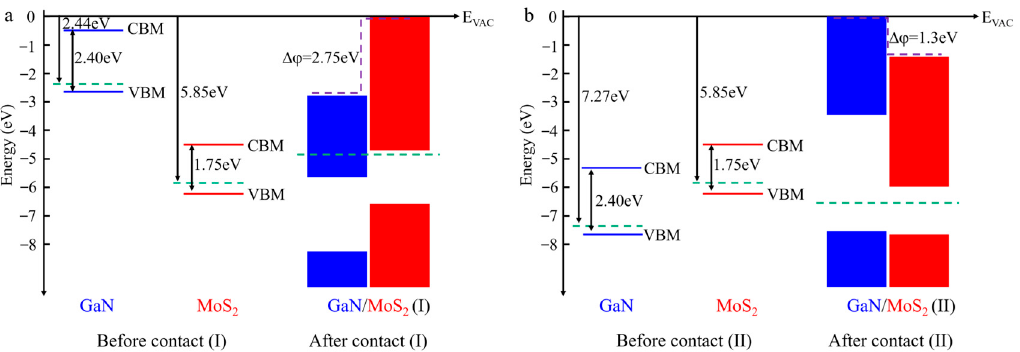
Figure 4. Schematic diagrams of energy band configurations of ( a ) GaN/MoS 2 (I) and ( b ) GaN/MoS 2 (II) heterojunctions before contact and after contact, respectively. The blue and red parts are GaN and MoS 2 , respectively. The Fermi energy levels are indicated by green dashed lines.